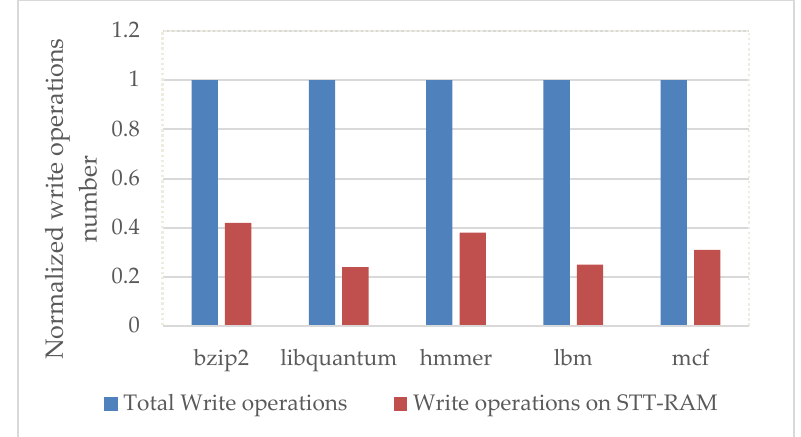
Figure 11. Comparison of the number of write operations normalized to the total write operations.